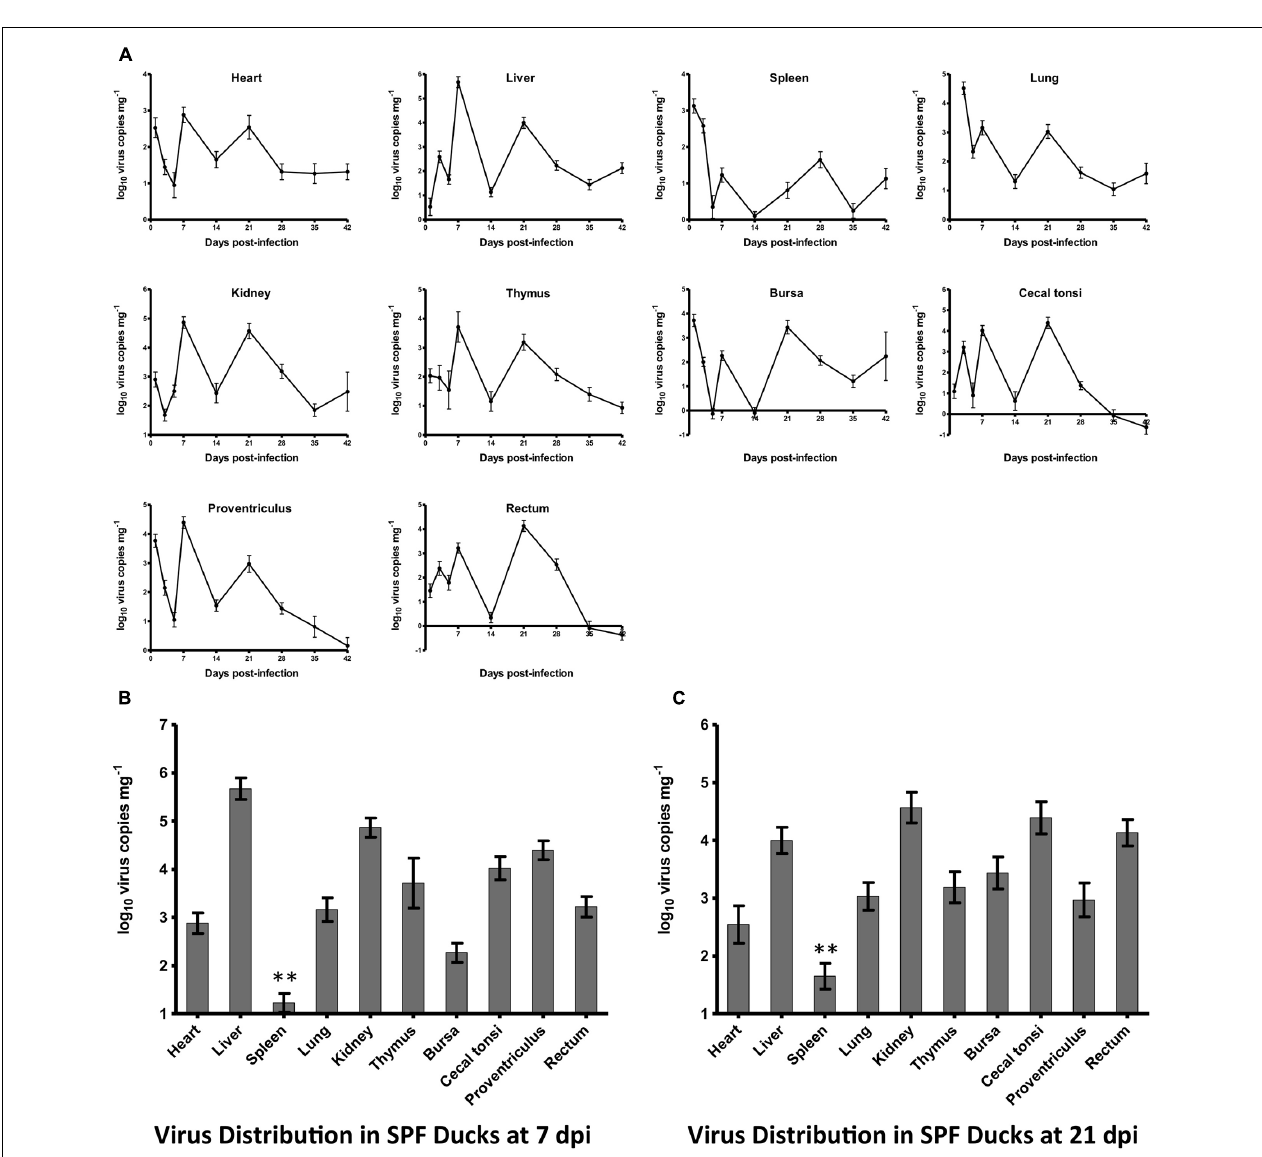
FIGURE 4 | Dynamic distribution of the novel FAdV-4 in experimentally infected SPF ducks. (A) Double replication peaks occurred in the heart, liver, spleen, lung, kidney, thymus, bursa, caecal tonsi, proventriculus, and rectum at 7 and 21 dpi. The peak concentrations of virus replication at 7 dpi (B) and 21 dpi (C) were compared, and the virus load in the spleen at both times was significantly lower than that in other tissues ( ∗∗ p <